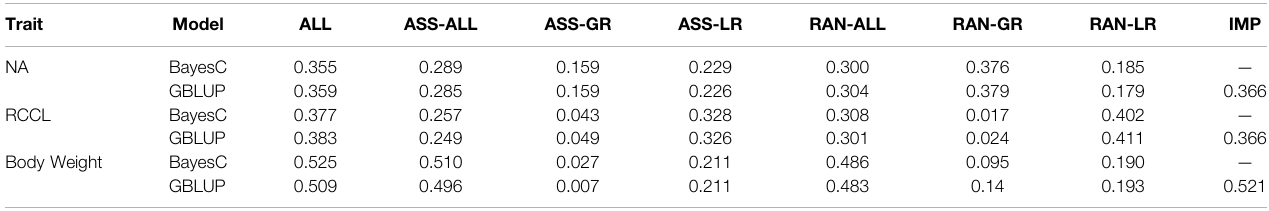
TABLE 1 | The cross-validation results (averaged Pearson correlation) based on random sampling for canine hip dysplasia (CHD), rupture of the cranial cruciate ligament (RCCL),andbodyweight.NA (cid:1) Norbergangle,GBLUP (cid:1) GenomicBestLinearUnbiasedPredictionModel.ALL (cid:1) usingallDNAarraymarkersinmulti-breedpopulation, ASS-ALL (cid:1) using associated markers in multi-breed population, ASS-GR (cid:1) using associated markers in Golden Retriever dogs, ASS-LR (cid:1) using associated markers in Labrador Retriever dogs, RAN-ALL (cid:1) using randomly selected markers in multi-breed population, RAN-GR (cid:1) using randomly selected markers in Golden Retriever dogs, RAN-LR (cid:1) using randomly selected markers in Labrador Retriever dogs, IMP (cid:1) using all the imputed markers in multi-breed population. Trait